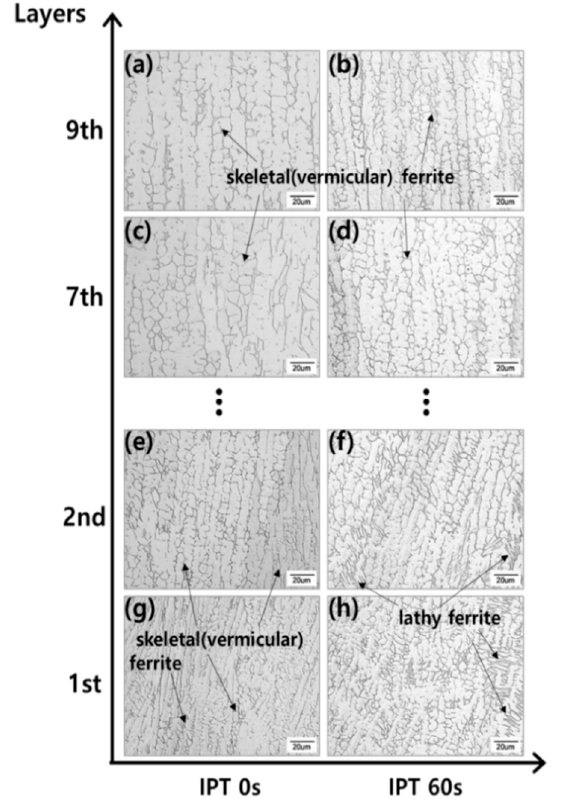
Figure 7. Optical-microscope images of the microstructure with respect to the IPT for STS 316L ( a ) 9th layer for 0 s IPT; ( b ) 9th layer for 60 s IPT; ( c ) 7th layer for 0 s IPT; ( d ) 7th layer for 60 s IPT; ( e ) 2nd layer for 0 s IPT; ( f ) 2nd layer for 60 s IPT; ( g ) 1st layer for 0 s IPT; ( h ) 1st layer for 60 s IPT.